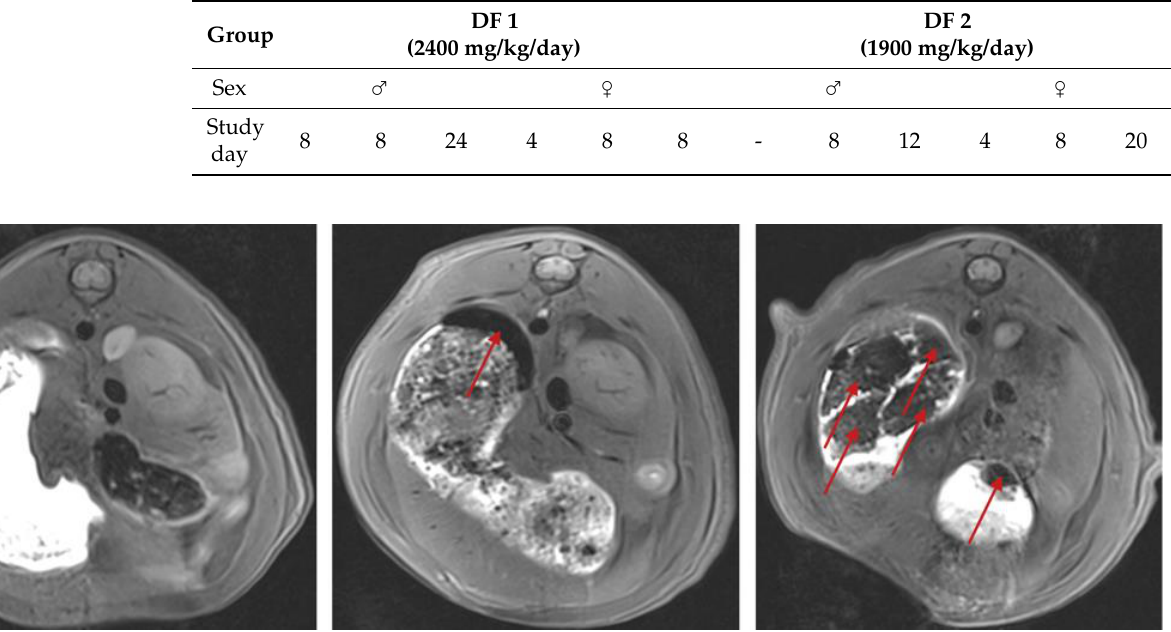
Figure 8. Pre-dose MRI image and MRI images of pharmacobezoars marked by red arrows at day 8 and day 16 in the stomach of a female rat after dosing of 2400 mg/kg/day SD-ASD in non-viscosity-enhanced vehicle (T1-weighted, transversal). Pre-dose MRI ( left ); onset of pharmacobezoar formation on day 8 with typical crescent shape of pharmacobezoar in the forestomach ( middle ) and pharmacobezoars observed on day 16 in the forestomach obtaining broken edges plus a smaller pharmacobezoar in the glandular stomach ( right ).